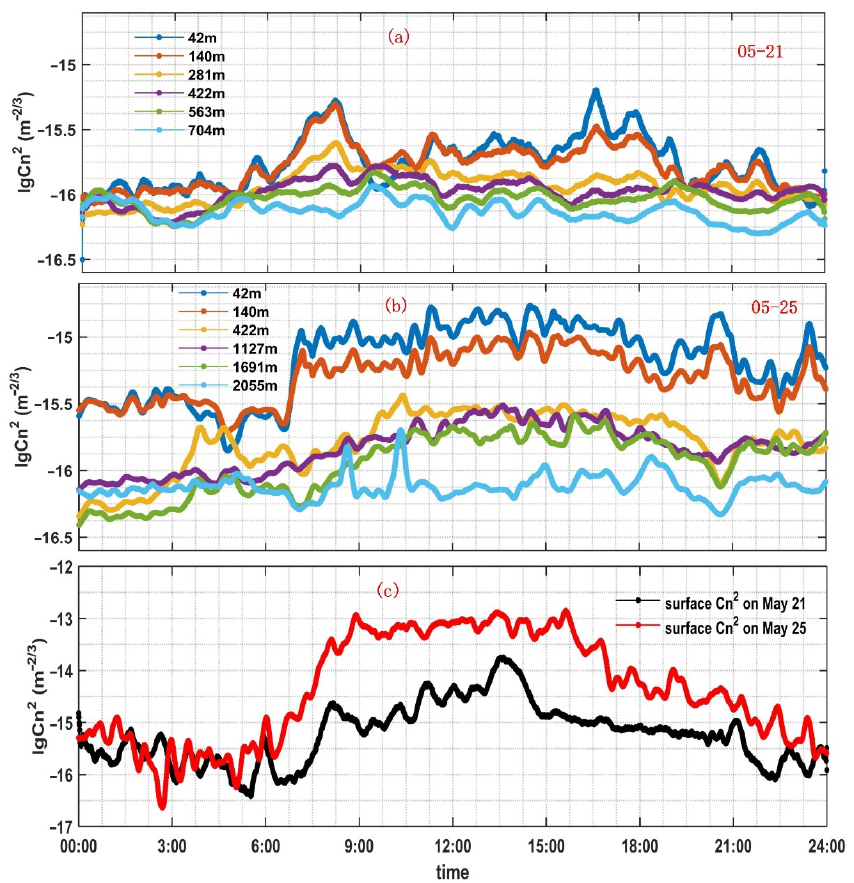
Figure 9. Diurnal profiles of 2 n C at different altitudes, ( a ) May 21; ( b ) May 25; ( c ) surface.